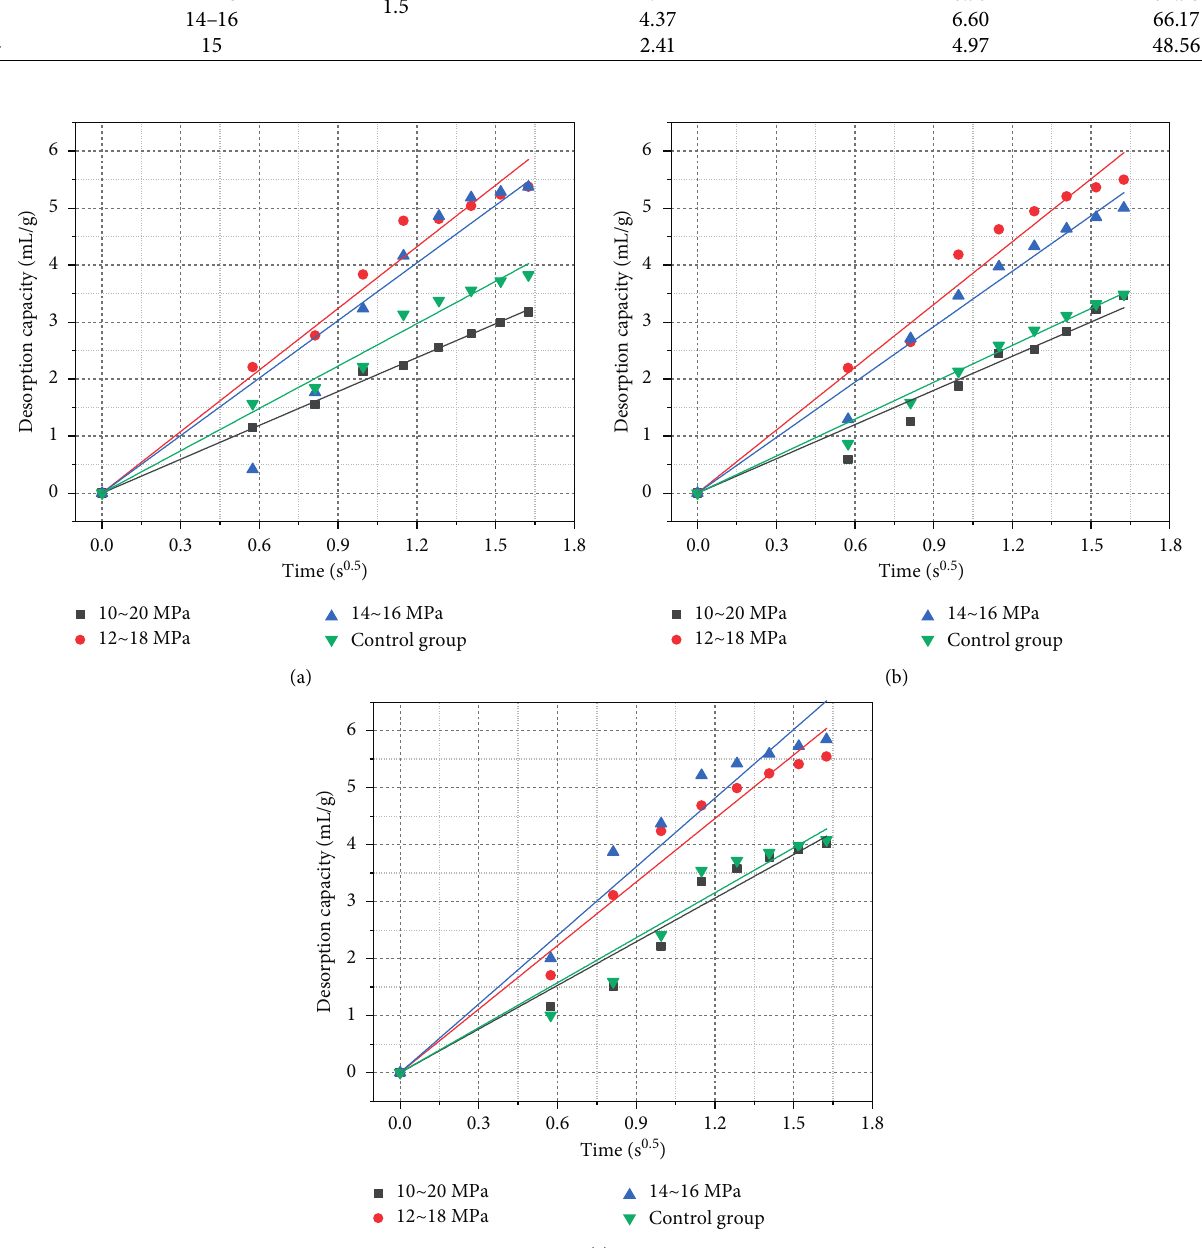
Figure 5: Fitting curves of the diffusion coefficients of the samples in the early stage under different loading amplitudes. (a) Equilibrium pressure of 0.5 MPa. (b) Equilibrium pressure of 1.0MPa. (c) Equilibrium pressure of